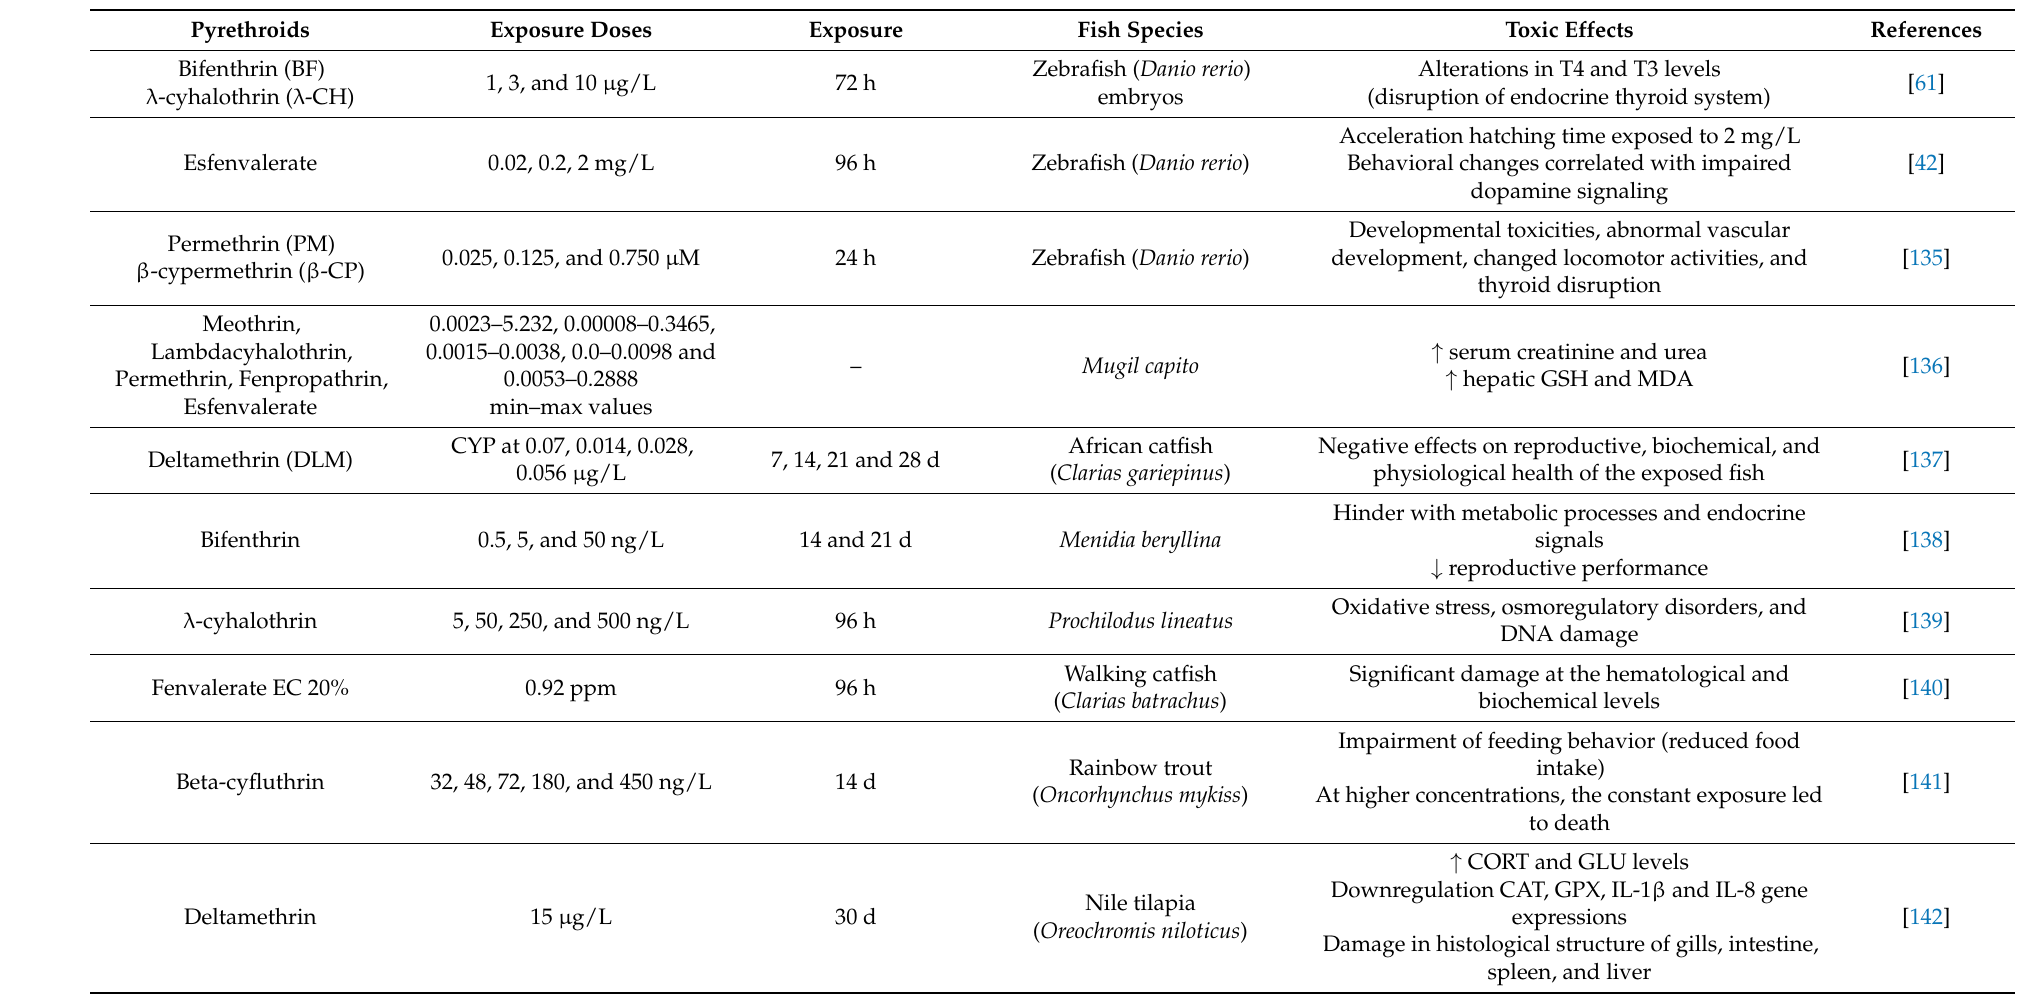
Table 1. Summary of toxic effects of some selected pyrethroid pesticides in some fish